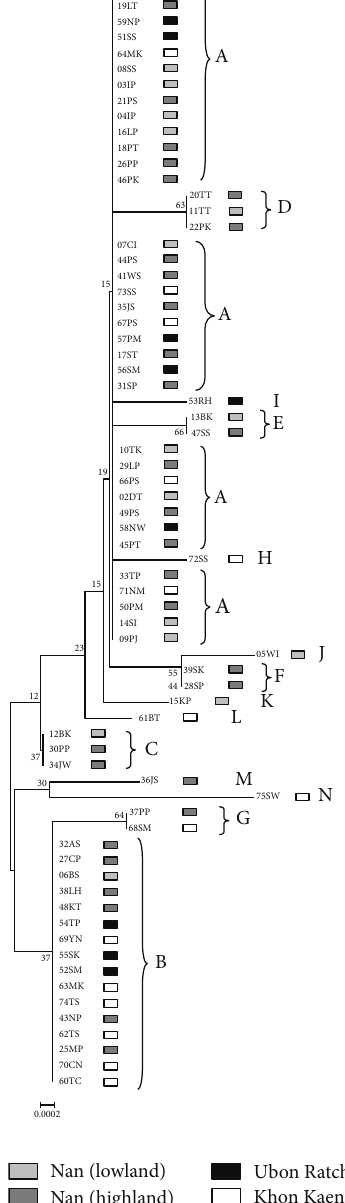
Figure 2: A neighbor-joining phylogram of mitochondrial cox1 gene of 73 T. saginata from 4 localities of Thailand. A to N indicates